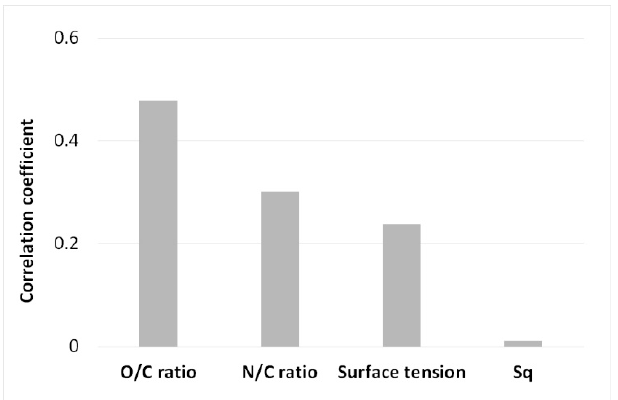
Table 4. Pearson’s coefficients. Figure 9. Graph of the correlation strength between the shear strength and the different surface characteristics.